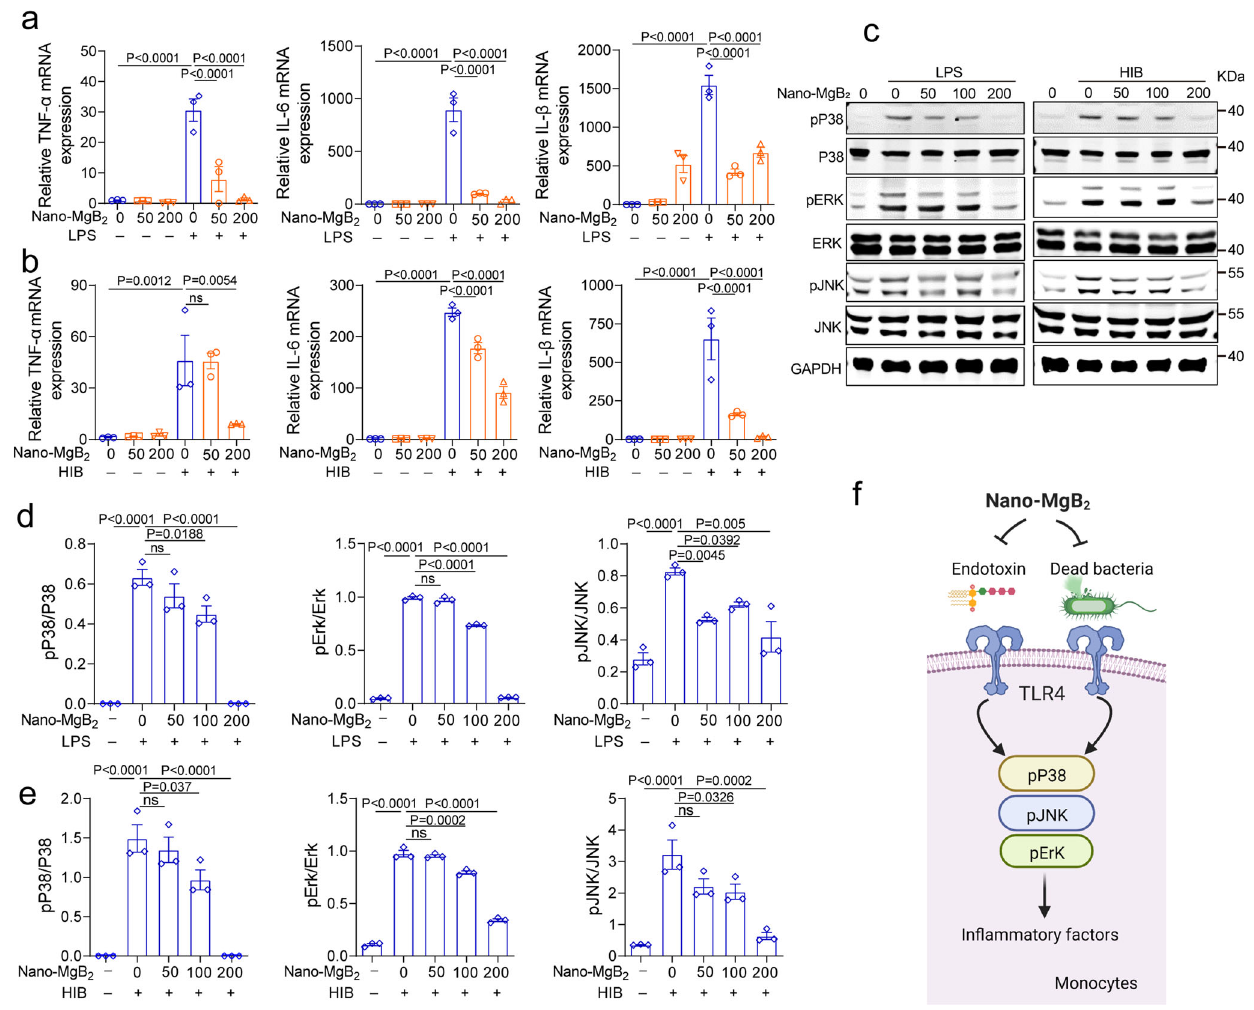
Fig. 5 | Nano-MgB 2 inhibited LPS- and dead bacteria-induced in fl ammation in Macrophage. a QPCR of TNF- α , IL-6, and IL-1 β in Raw 264.7 cells treated with 100ng/mL LPS with 50 and 200 μ g/mL Nano-MgB 2 for 3h ( n =3 biological inde- pendent cells). b QPCR of TNF- α , IL-6, and IL-1 β in Raw 264.7 cells treated with 5×10 7 dead bacteria (HIB, heat-inhibited bacteria, P. aeruginosa ) with 50 and 200 μ g/mL Nano-MgB 2 for 3h ( n =3 biological independent cells). c Western Blot of pP38/P38, pErk/Erk, and pJNK/JNK in Raw 264.7 cells treated as in ( a ) for